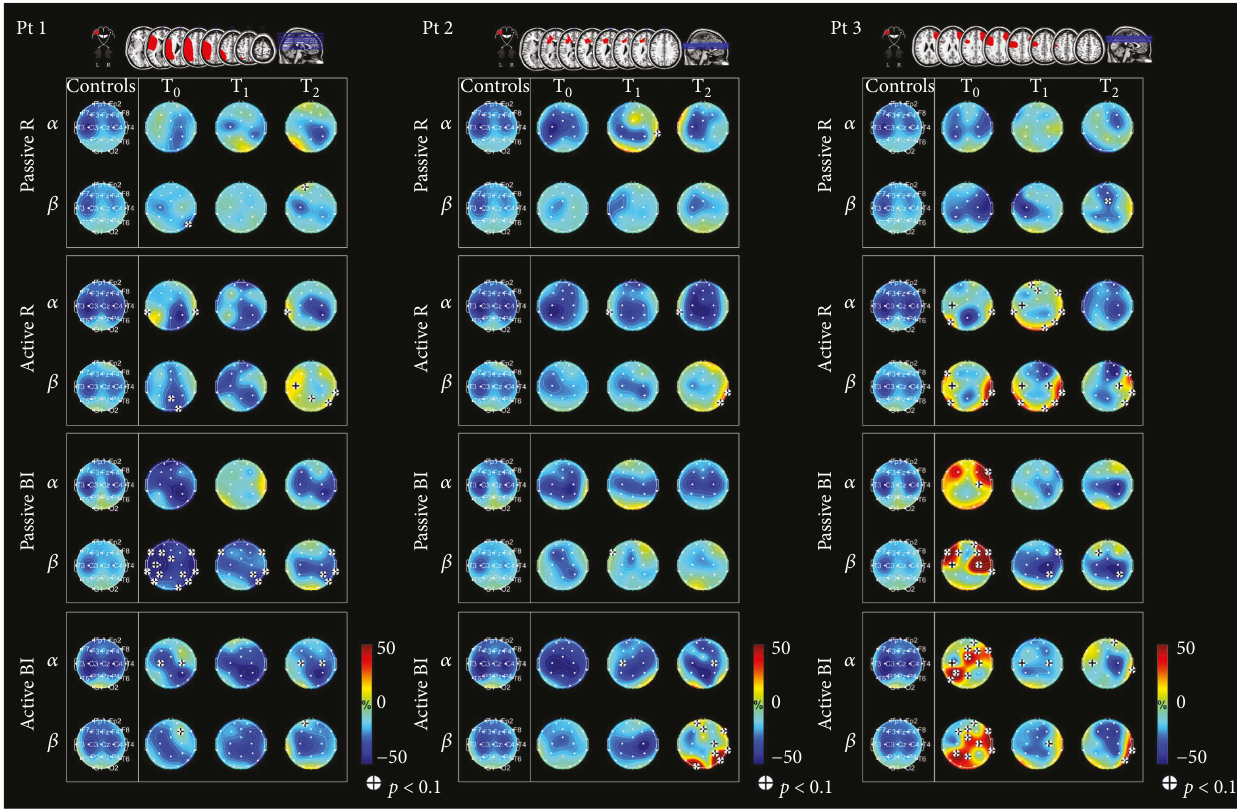
Figure 1: Lesions displayed on a magnetic resonance imaging brain template and topographic maps showing ERD/ERS values. ERD/ERS maps in the alpha and beta bands during passive and active movements with the a ff ected hand and during bimanual passive and active movements (patient numbers 1, 2, and 3). Blue indicates maximal ERD. The t -test was applied individually for each patient in order to compare the ERD/ERS map of each patient to the mean ERD/ERS map of the controls ( p < 0 1 (| t | > 1.895) indicated by